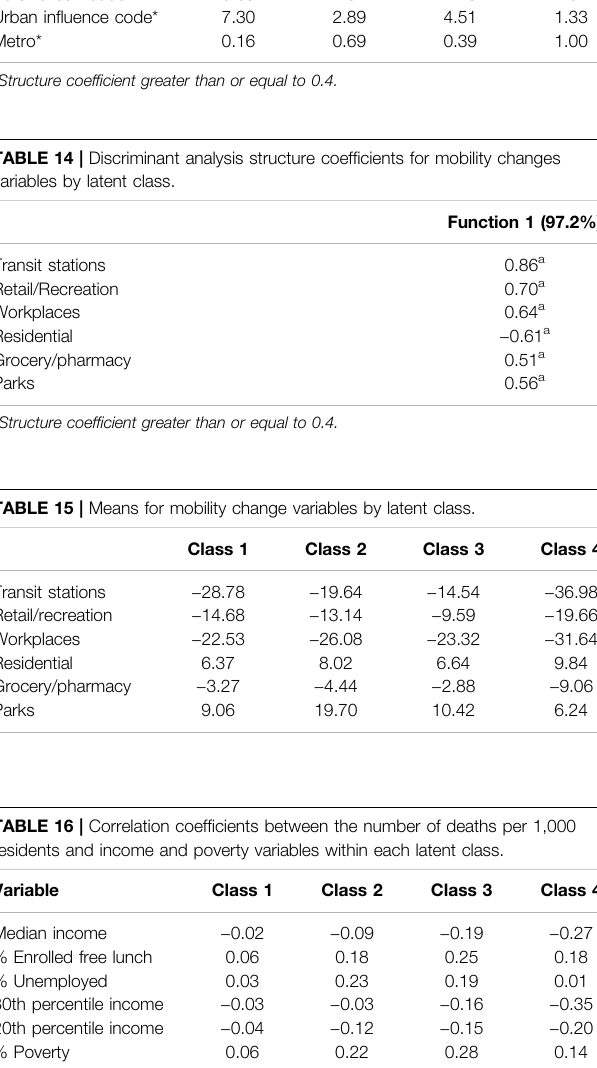
Table 9 . Class 4 had the highest 80th percentile income, 20th percentile income, median household income, and median household income as percent of the state total. The lowest